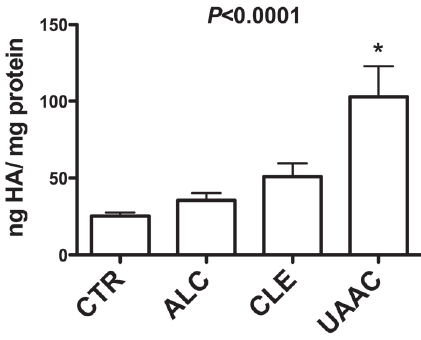
Figure 1 - Hyaluronic acid content in tear fluid of UAAC patients, normal donors and allergic conjunctivitis. HA was measured in tears by a non-competitive fluorometric ELISA- like assay. The HA content in tears of all UAAC eyes, in the contralateral eyes (CLE), in eyes of normal donors (CTR) and allergic conjunctivitis (ALC) was 102.9 ± 19.9 ng/mg protein; 51.02 ± 8.5 ng/mg protein; 25.2 ± 2.3 ng/mg protein and 35.5 ± 4.5 ng/mg protein respectively. The statistical analysis was performed using ANOVA followed by Bonferroni's post test. Abbreviations: UAAC, unilateral acute adenoviral conjunctivitis; CLE, contralateral non-affected eye; ALC, Allergic